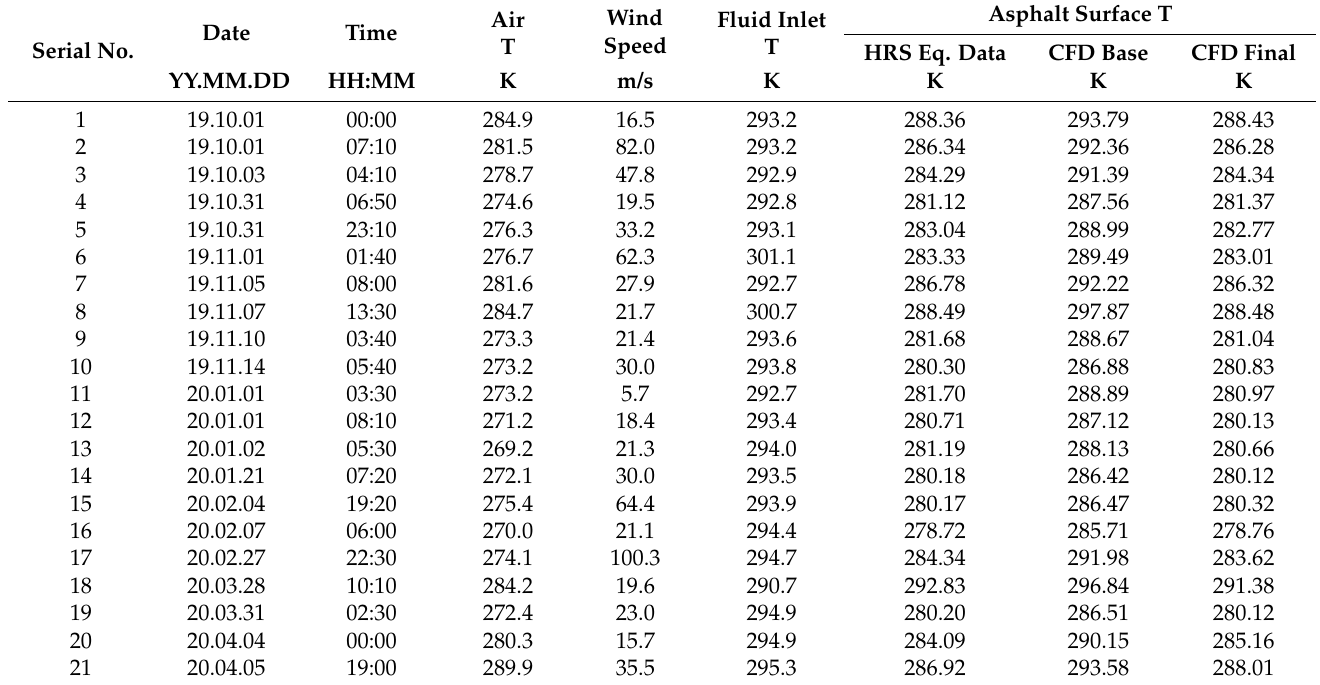
Table 3. Asphalt surface temperatures obtained from experimental on-site measurements (HRS equilibrium data) and starting (base) and optimized (final) CFD simulation